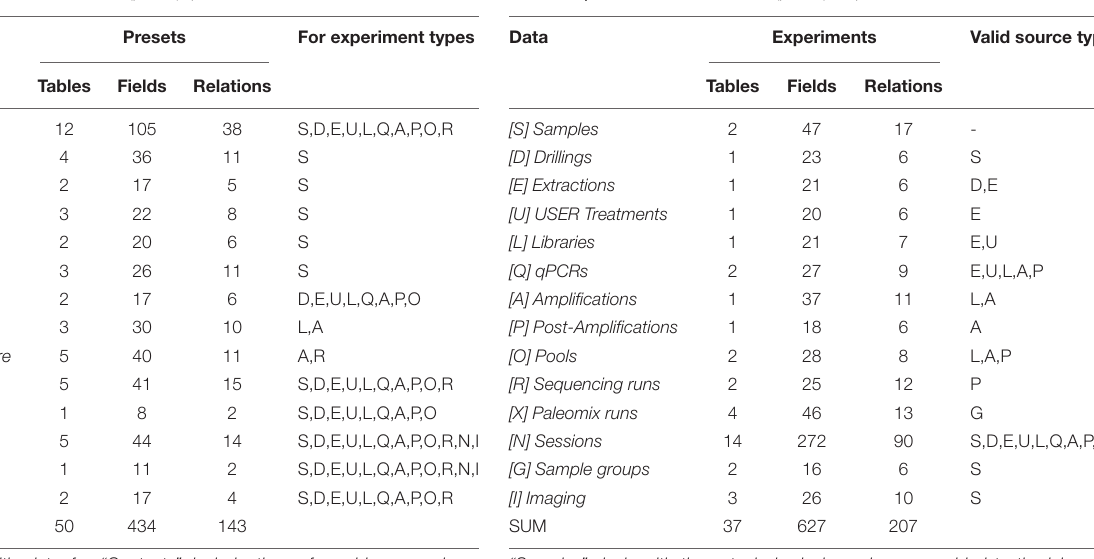
TABLE 1 | Data structure overview (part 1): presets. TABLE 2 | Data structure overview (part 2): experiments and related data.